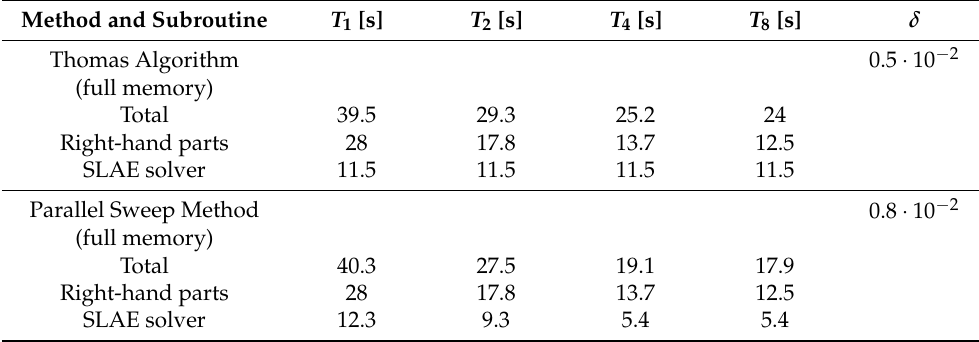
Table 3. Results of experiments for Problem 2 using the full memory approach with grid m = 32 × 2 20 , N = 64.